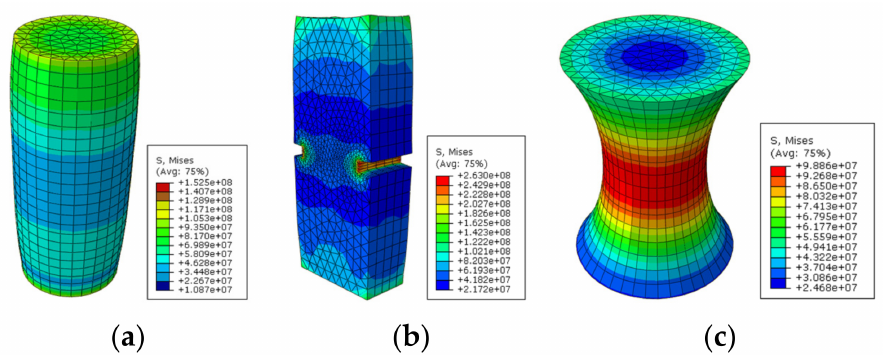
Figure 3. Stress state in direct tensile test configurations. ( a ) Cylindrical geometry; ( b ) double-notched geometry; and ( c ) dog-bone geometry.